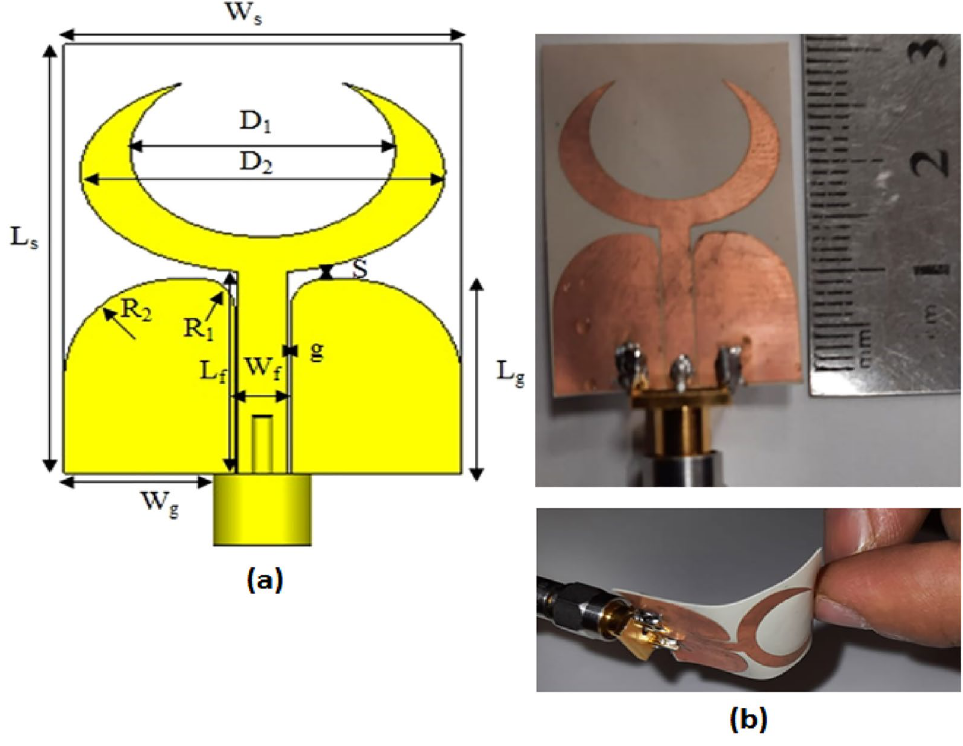
Figure 1. Flexible single antenna configuration, ( a ) 2 D view, ( b ) fabricated photo